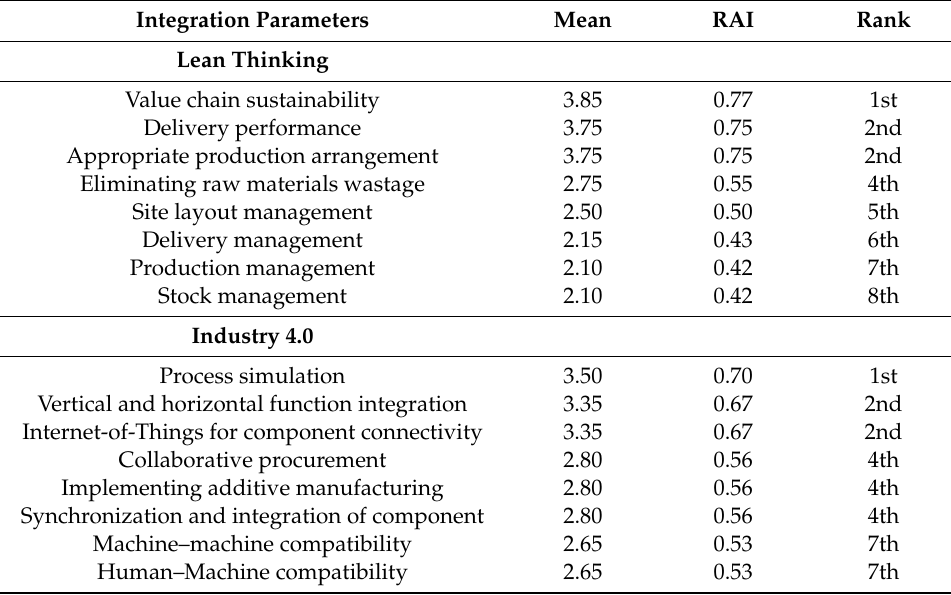
Table 20. Parameters for e ff ective integrating of lean thinking approach and Industry